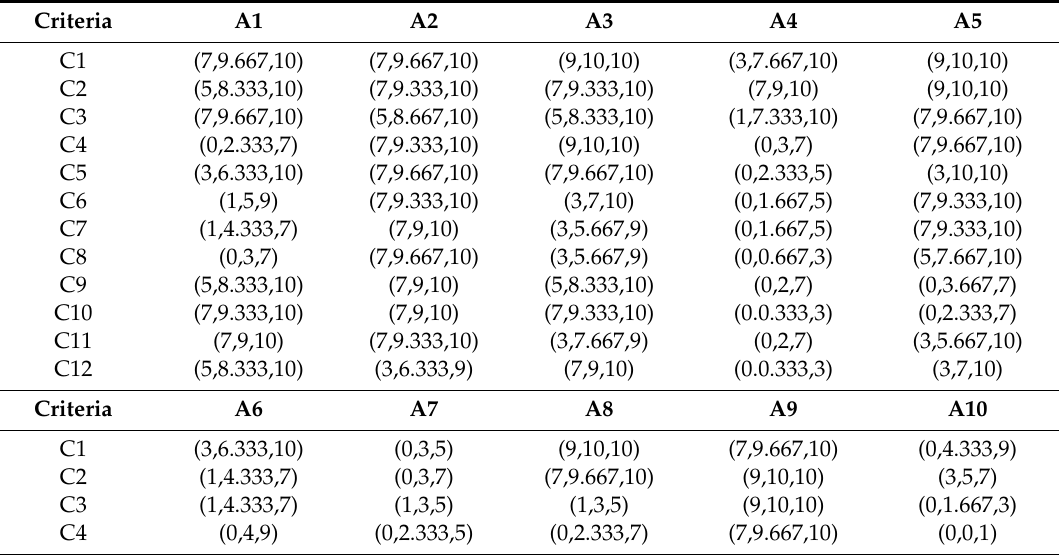
Table 10. Fuzzy aggregated decision